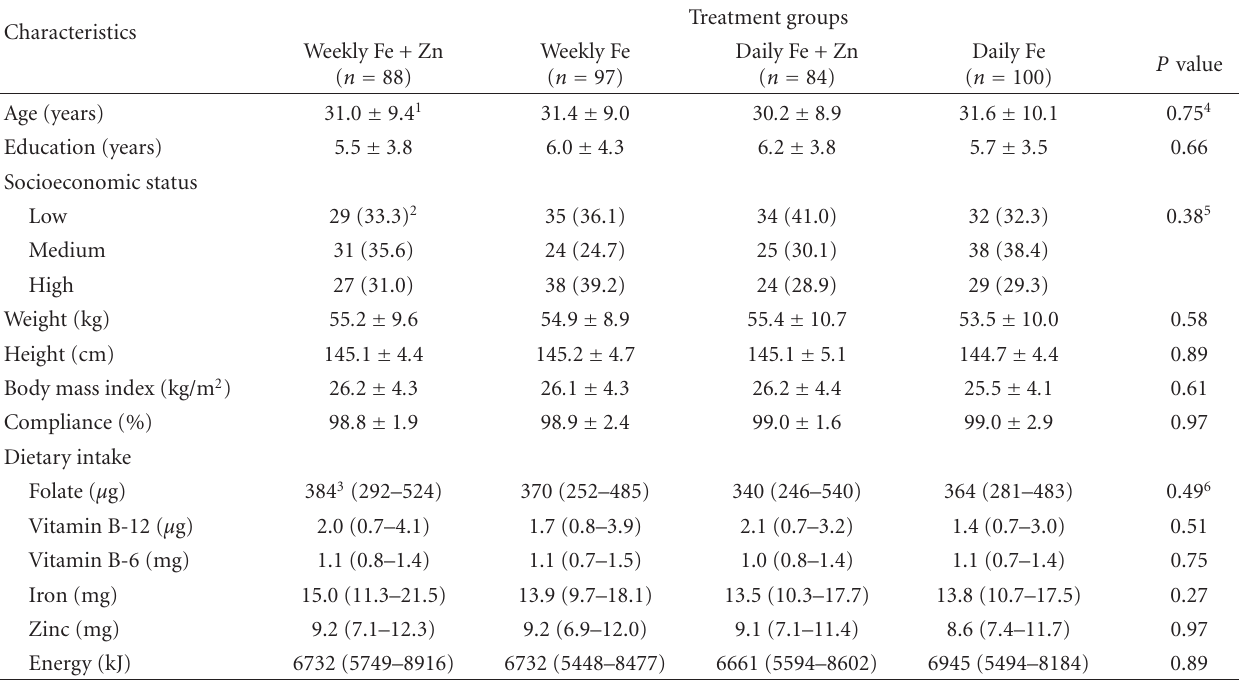
Table 1: Selected baseline characteristics of the four treatment groups.